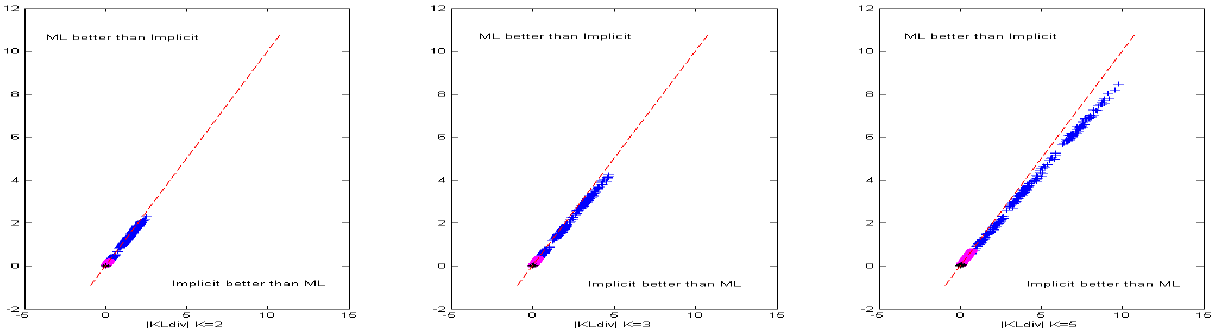
Figure 2: Comparison of KL divergence obtained by Implicit approach versus the method of maximum likeli- hood for the same datasets (upper triangle : ML is better, versus lower triangle : Implicit approach is better) with respect to dataset size ( N = 100 , 1 . 000 , 10 . 000, resp. blue, magenta and black points) and maximum cardinality ( K = 2 , 3 ,